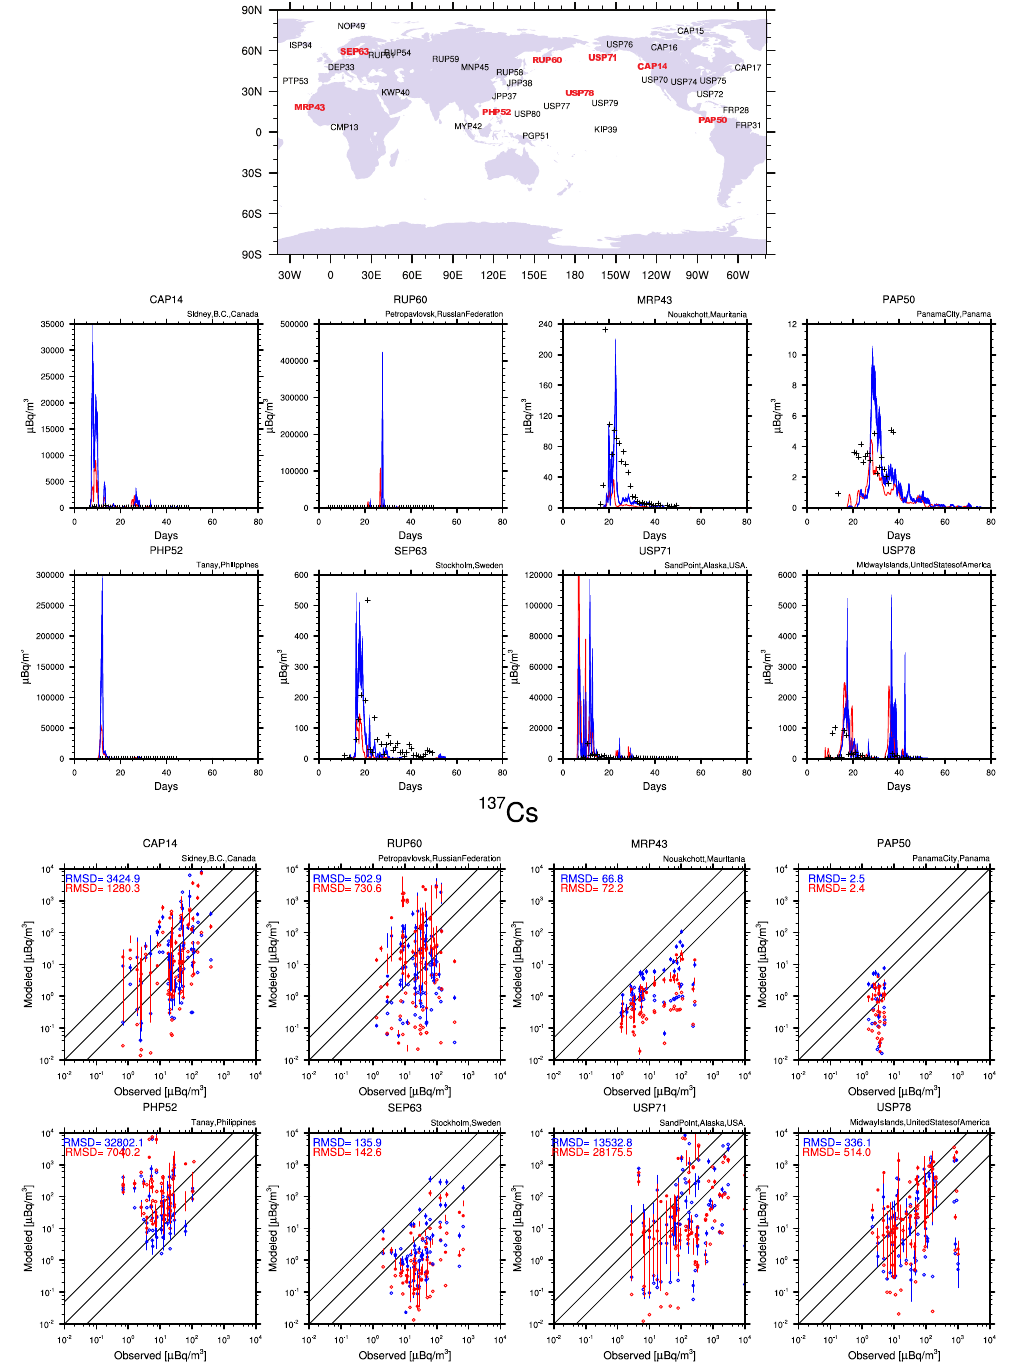
Fig. 4. Top: CTBTO measurement network station location and code for 137 Cs for the subset of stations with measurements available used in our study. Stations shown in our study are highlighted in red. Middle: Observed (black crosses) and modeled (solid lines) surface concentrations of 137 Cs at the eight selected stations. T255 horizontal resolution is shown in blue and T106 in red. The time axis represents days after the accident. Bottom: Modeled (Stoehlker et al. (2011) – solid circles; Chino et al. (2011) – open rhombi) versus observed surface concentrations of 137 Cs at the eight stations. The diagonal lines represent the 1:1 ratio and the factor of 5 over- and underestimates.